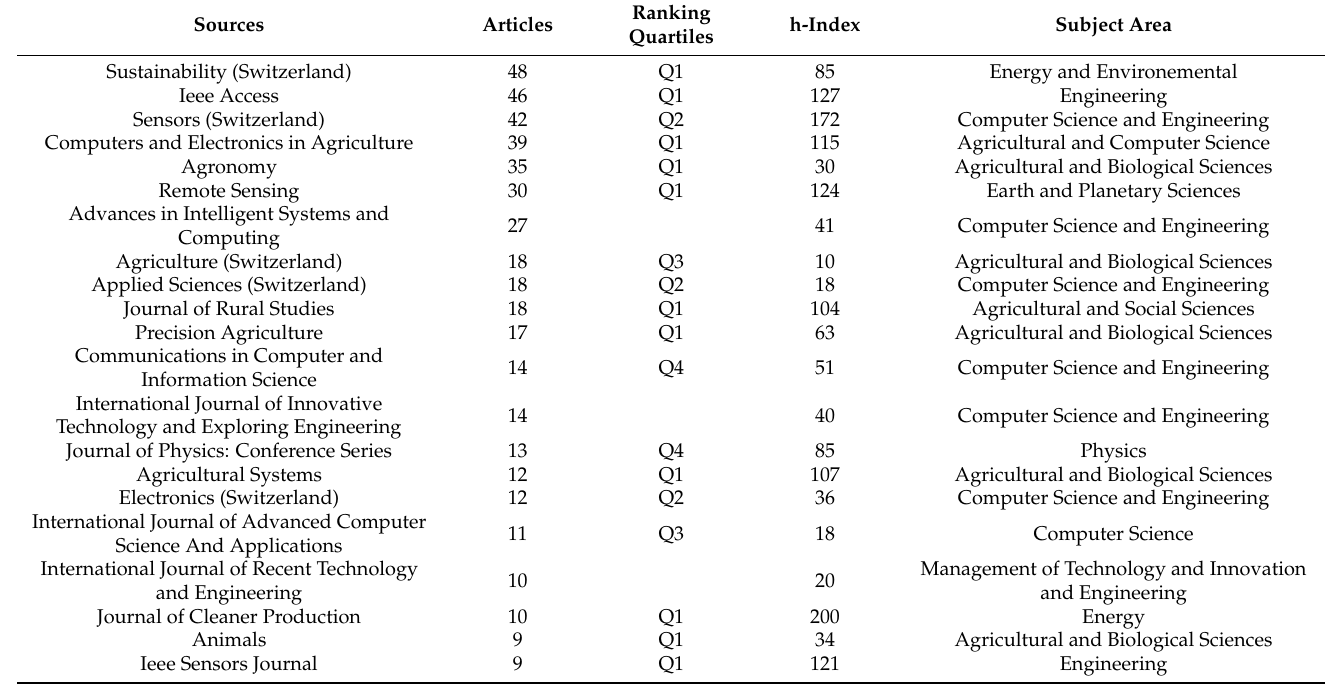
Table 1. Most relevant resources in the field of smart and precision